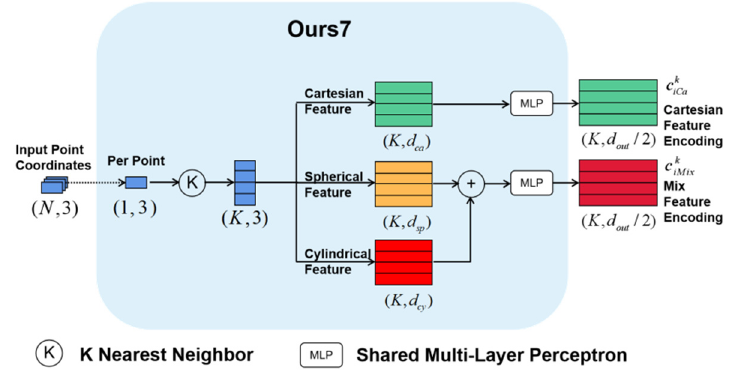
Figure 12. The structure of Ours7.